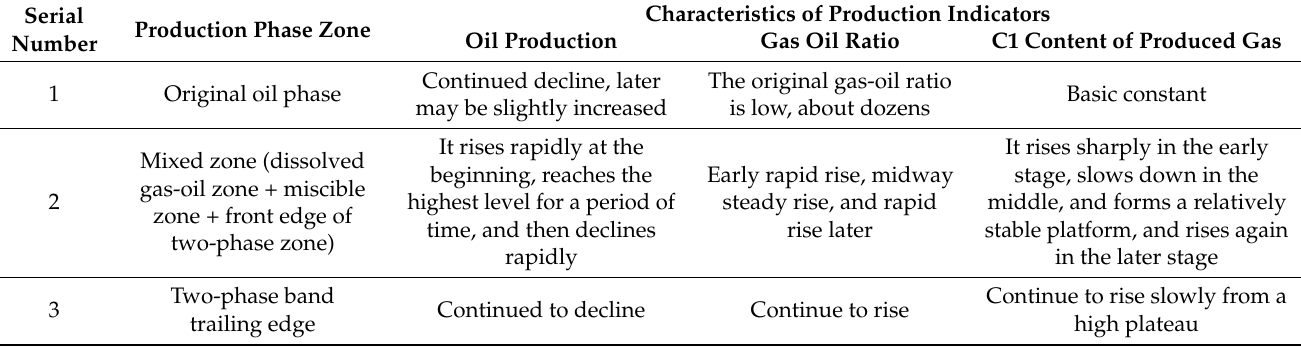
Table 3. Production index characteristics corresponding to each production phase zone of miscible flooding mode.